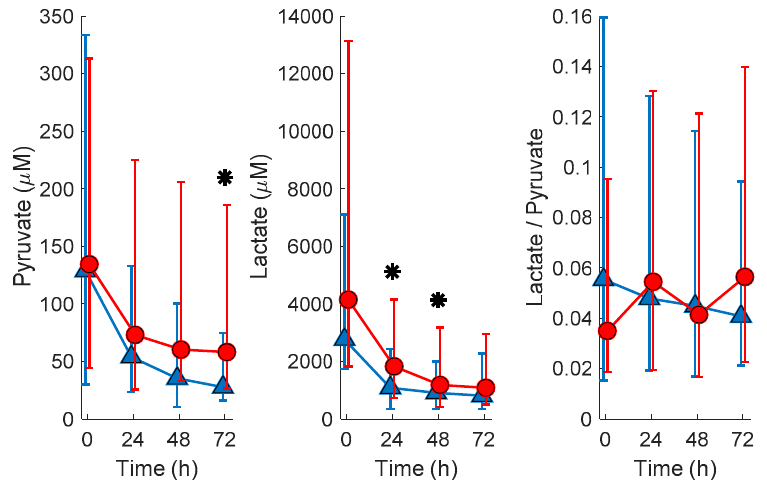
Figure 1. Evolution of pyruvate and lactate concentrations and lactate/pyruvate in plasma samples from newborns with normal (blue ∆ and error bars are median and 25th and 75th percentile, respectively) and pathologic (red o and error bars are median and 25th and 75th percentile, respectively) MRI outcomes. Note: normal vs. pathologic at 0 h N = 13 and 23; at 24 h N = 20 and 30; at 48 h N = 22 and 28; and at 72 h N = 20 and 32, respectively; * indicates p -vales below 0.05 (Wilcoxon rank sum test) for comparing normal vs. pathologic MRI outcomes; blood samples were extracted at birth and at 24, 48, and 72 h after the administration of the first dose of medication/placebo.